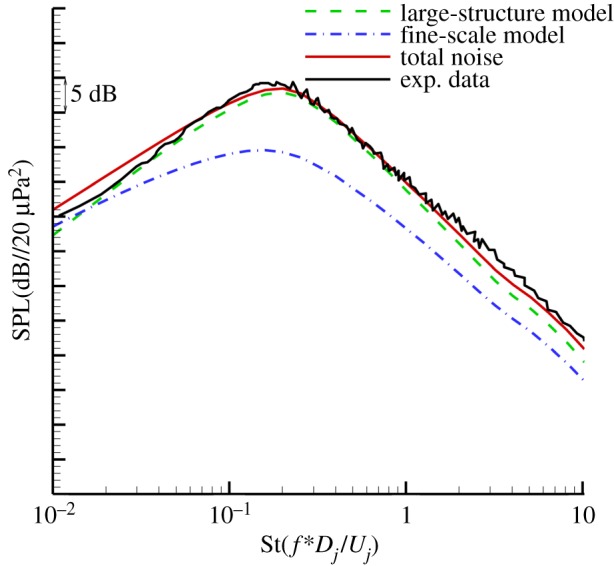
Comparison of spectra at 30° to the jet axis and R = 100D (Mj = 0.97). (Online version in colour.)